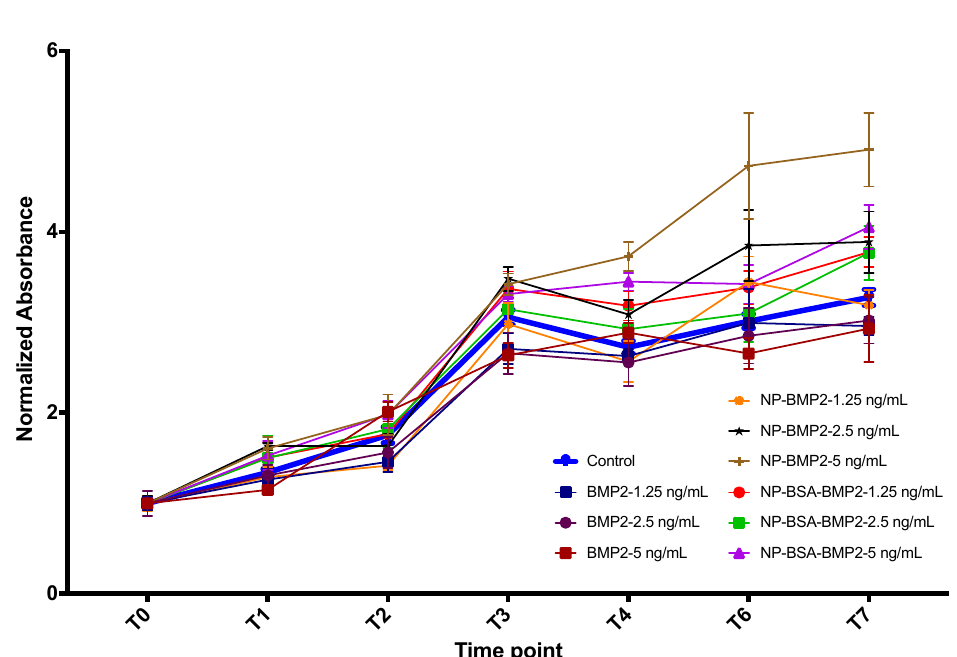
Figure 7. Proliferation of human mesenchymal stromal cells (MSCs) as measured by sulphorhodamine (SRB) absorbance. Results were normalized to T0 in each group.